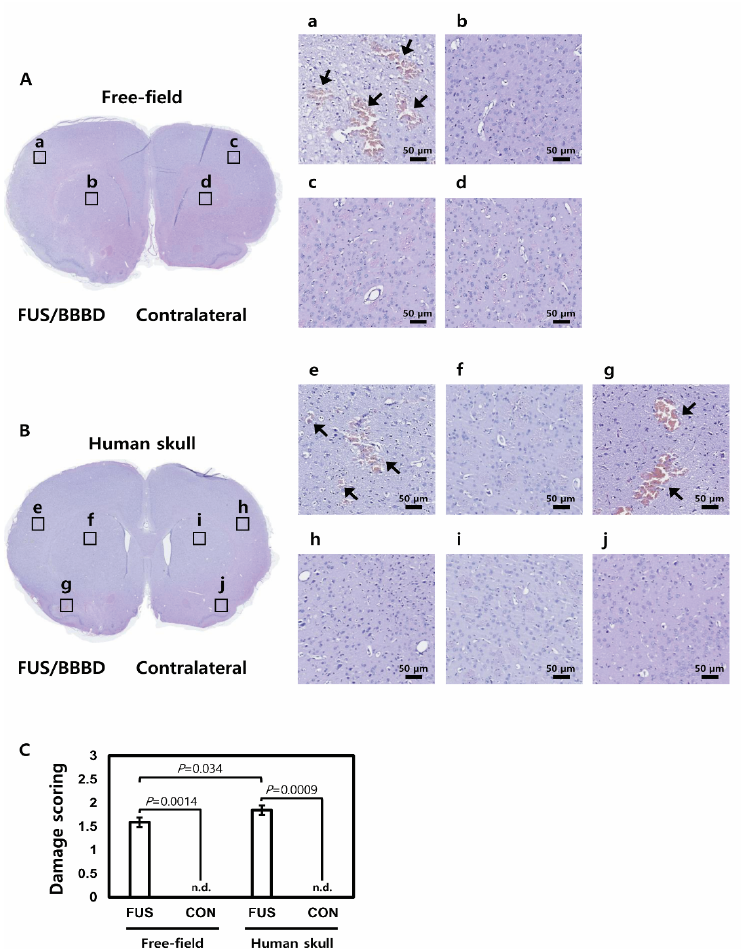
Figure 8. Histological analysis of the rat brain sections after FUS induced the BBB opening using hematoxylin and eosin (H&E) staining. ( A ) The upper brain was sonicated without the human skull. The enlarged images showed ( a , b ) FUS/BBBD regions and ( c , d ) contralateral regions (scale bar = 50 µ m). ( B ) The bottom brain was sonicated with the human skull. The enlarged images showed FUS/BBBD regions ( e – g ) and contralateral regions ( h – j ) (scale bar = 50 μ m). The black arrow shows cerebral microhemorrhages induced by FUS. ( C ) The damage score of H&E staining for each of the FUS groups was represented by a bar graph. All data are presented as the mean ± standard deviation ( n = 3 slides). n.d., not detected. Analysis of variance with a multiple comparisons test was performed, and the results are as follows: comparison with contralateral versus FUS/BBBD ( p = 0.0014 in the free field, p = 0.0009 in the human skull) and FUS/BBBD in the free field versus FUS/BBBD in the human skull ( p = 0.034).